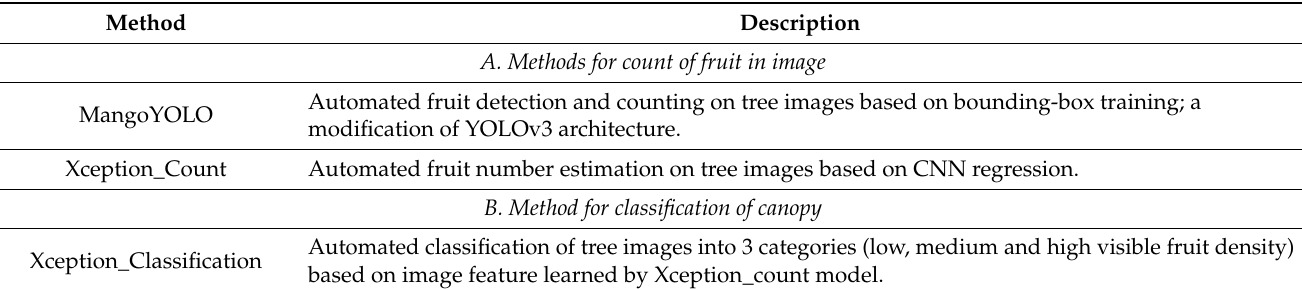
Table 1. Methods used in (A) counting of fruit in images, (B) classification of canopy images and (C) fruit load (count) of whole tree. Method